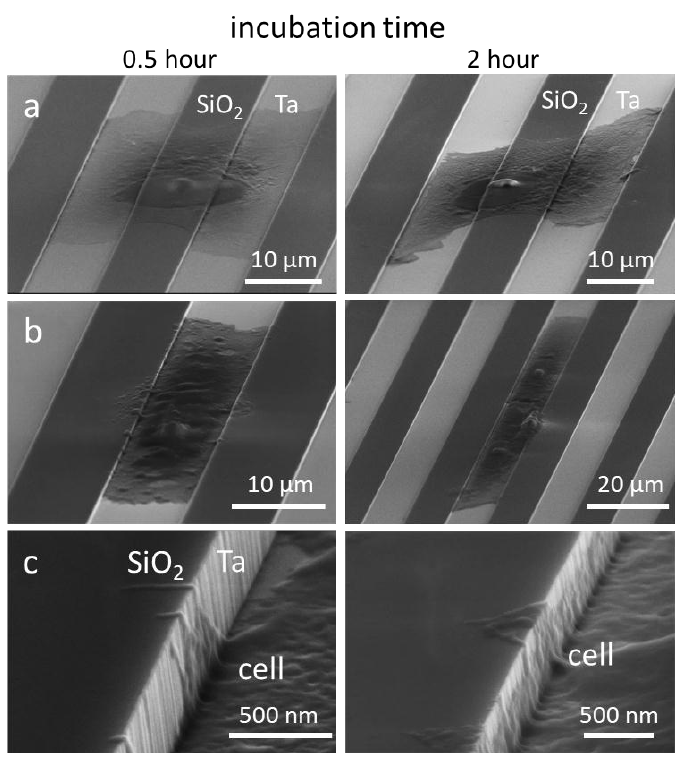
Figure 10. Typical 70°-tilted SEM micrographs of 0.5 and 2 h incubated cells on 10 μm comb structures with cell nuclei centered on ( a ) silicon oxide lines and ( b ) tantalum coated trenches. ( c ) High-magnification of pseudopodia on the trench sidewalls.